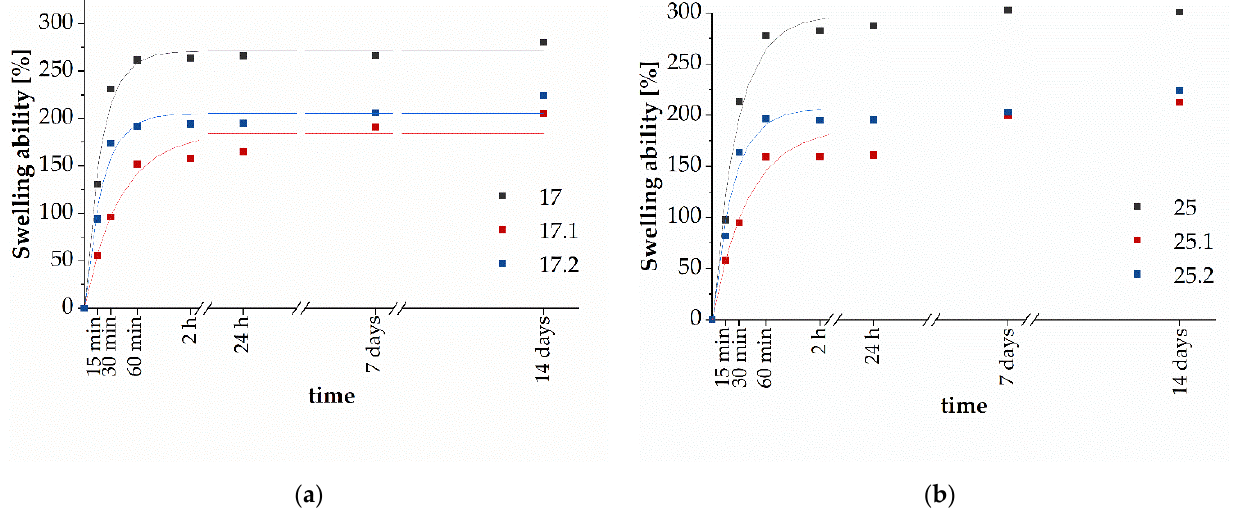
Figure 4. Kinetics of swelling of samples 17, 17.1, and 17.2 ( a ), and 25, 25.1, and 25.2 ( b ). Table 2. Rate parameter ( τ ) and equilibrium swelling ( S e ) values of investigated materials.